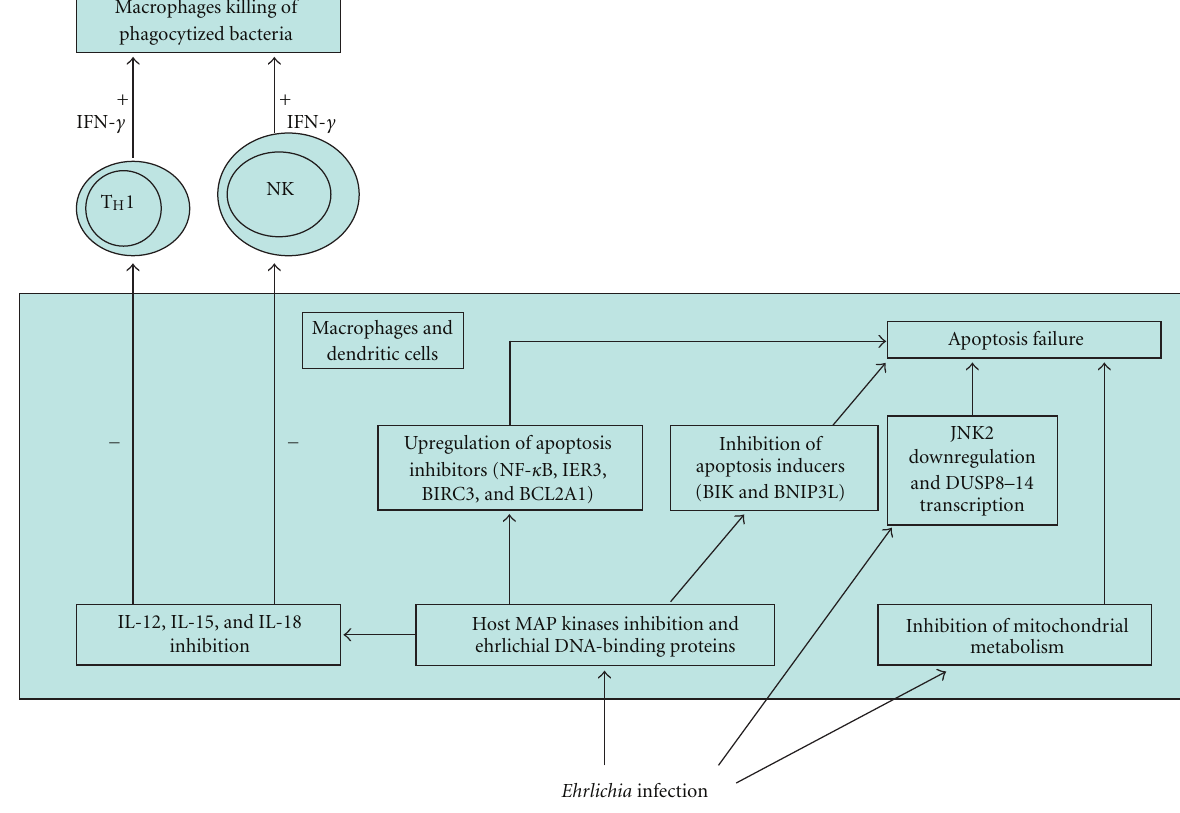
Figure 12: Modulation of host cell gene expression in ehrlichial